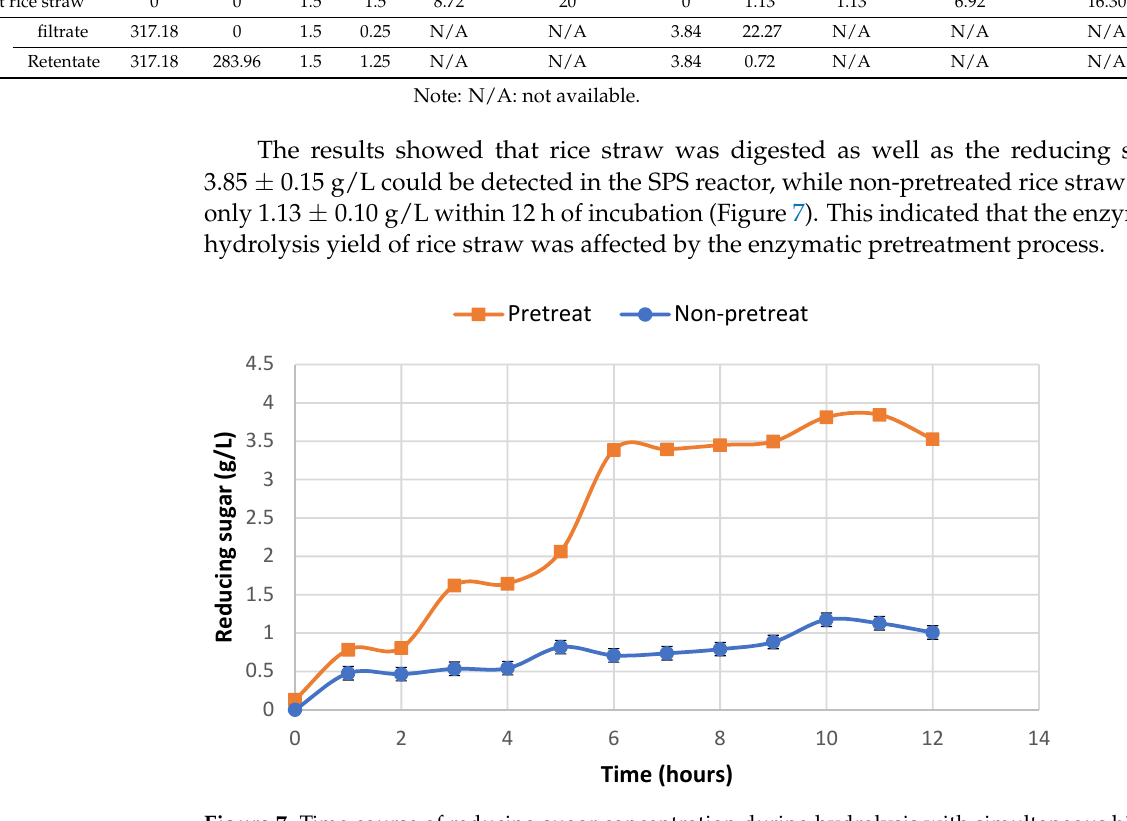
Table 6. Reducing sugar production from non-pretreated and pretreated rice straw.